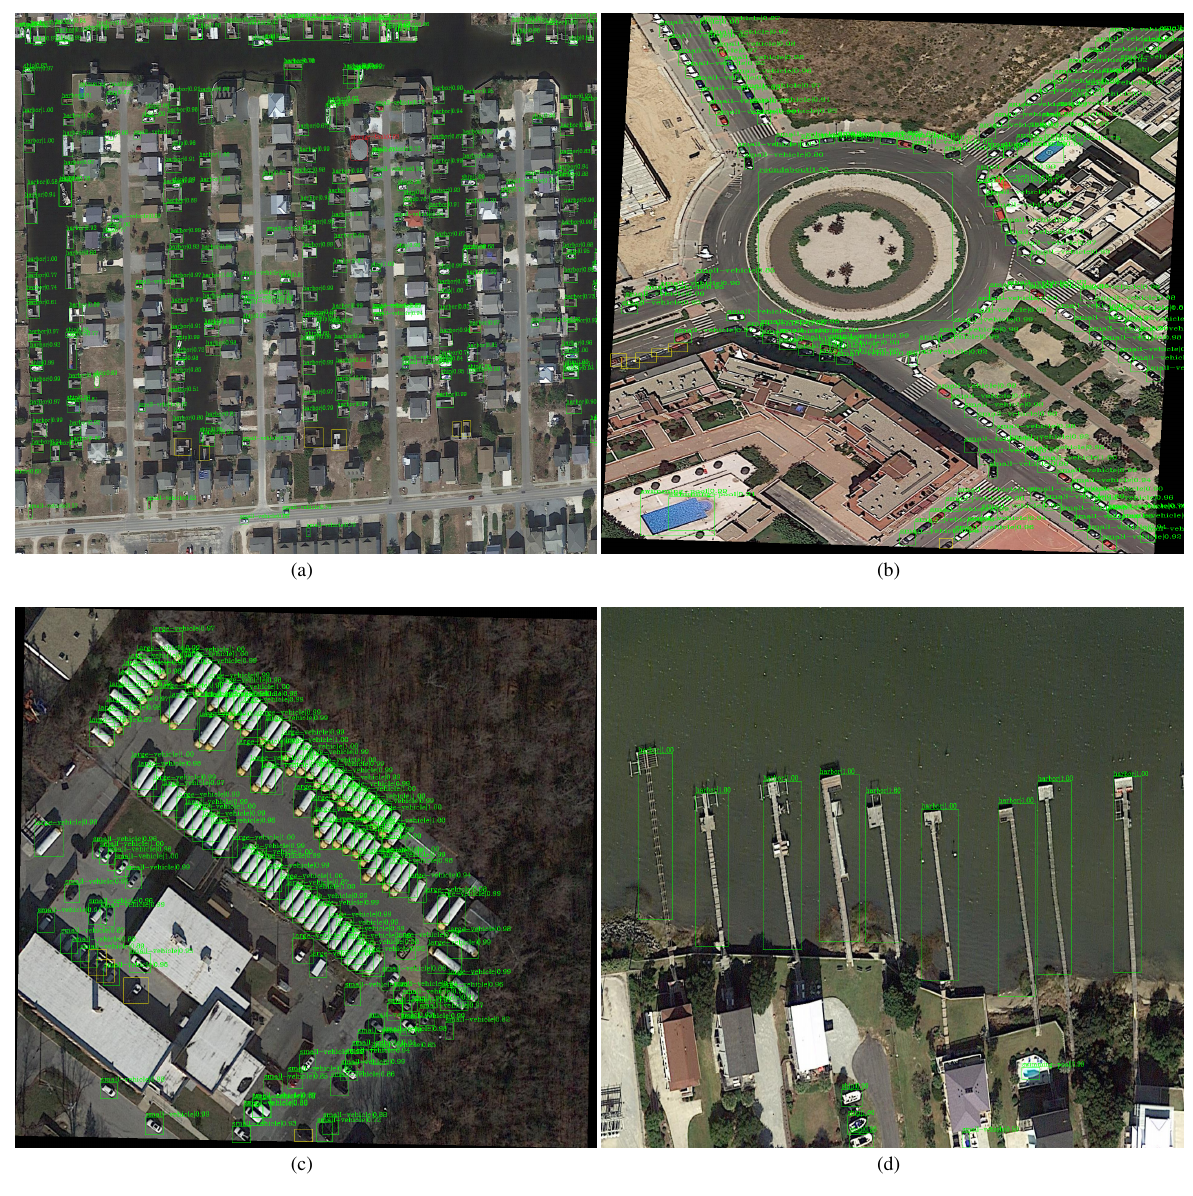
Figure 4. The samples of detection results of the proposed